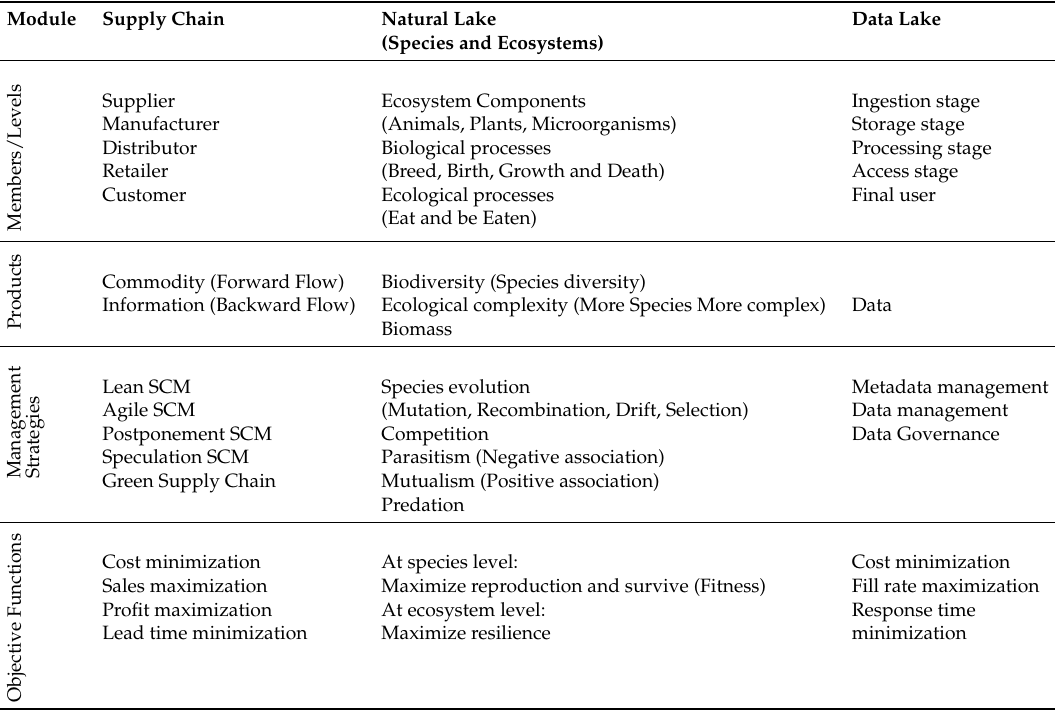
Table 1. Analogy of Supply Chain, Ecosystem and Data